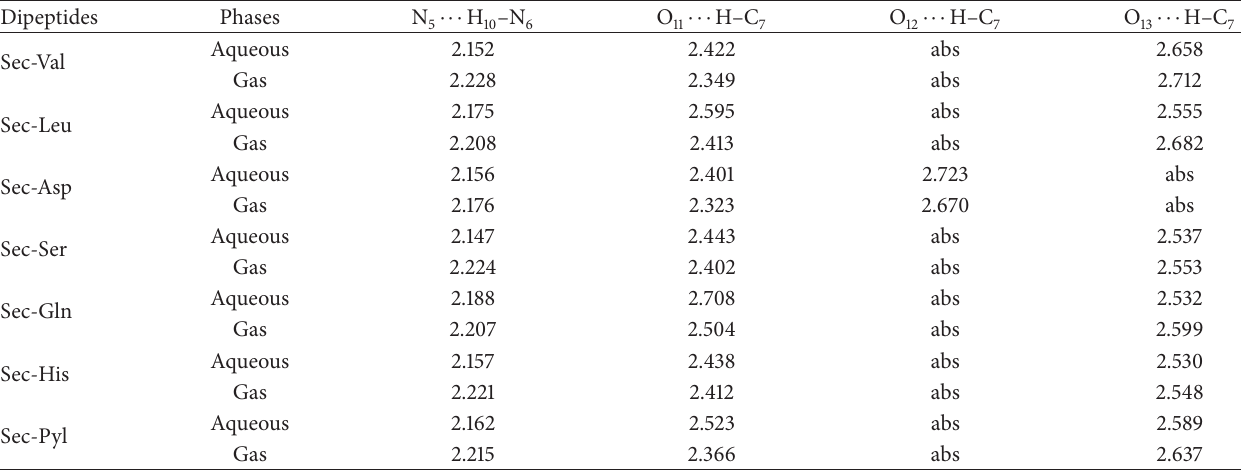
a Maximum deviation from average values. Table 6: H-bond distances a (in angstrom) for the intramolecular H-bond interactions detected in the dipeptide structures in both the phases. Dipeptides